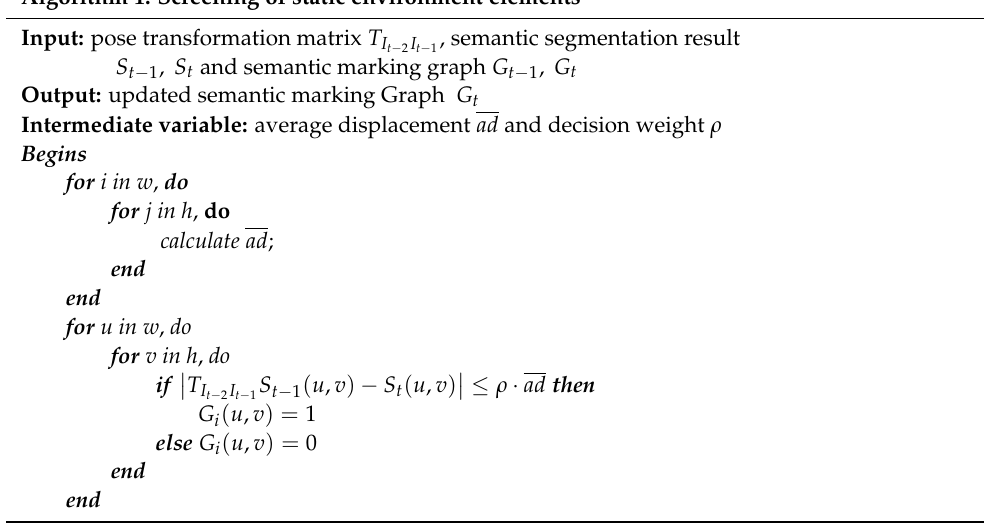
Figure 7. Schematic diagram of environmental elements selection based on context information. Algorithm 1. Screening of static environment elements